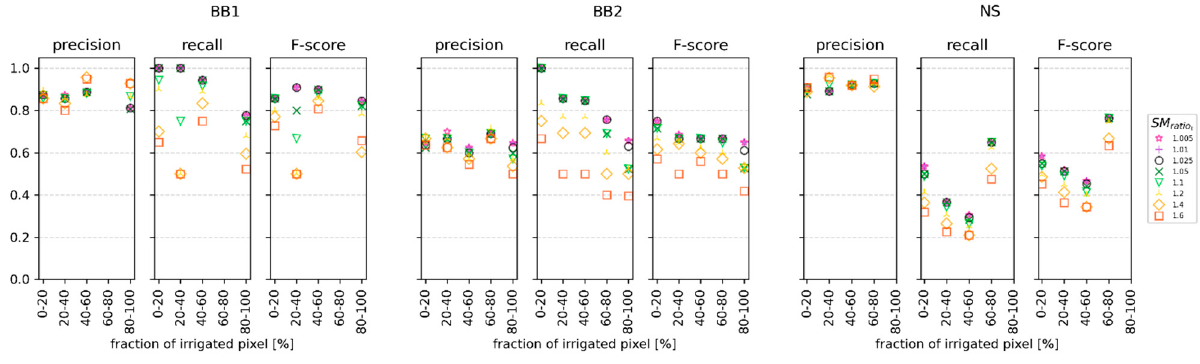
Figure 4. Detection accuracy expressed as precision, recall and F-score, for the irrigation period based on actual irrigation dates reported by farmers (IP actual ). The results are grouped by the fraction of irrigated area within S1-SSM pixels.